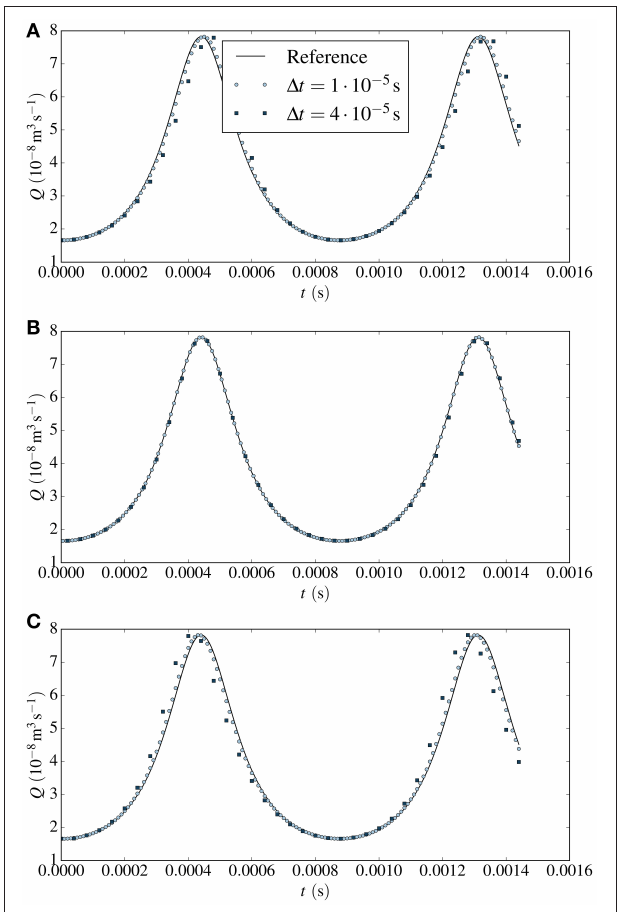
FIGURE 5 | Flow rates Q plotted against time for two different time steps 1 t for the links-in-series test case with 1 P = − 3200Pa. Results from the forward Euler method are given in (A) , results from the midpoint method in (B) and results from the semi-implicit method in (C) . The solid line represents the reference